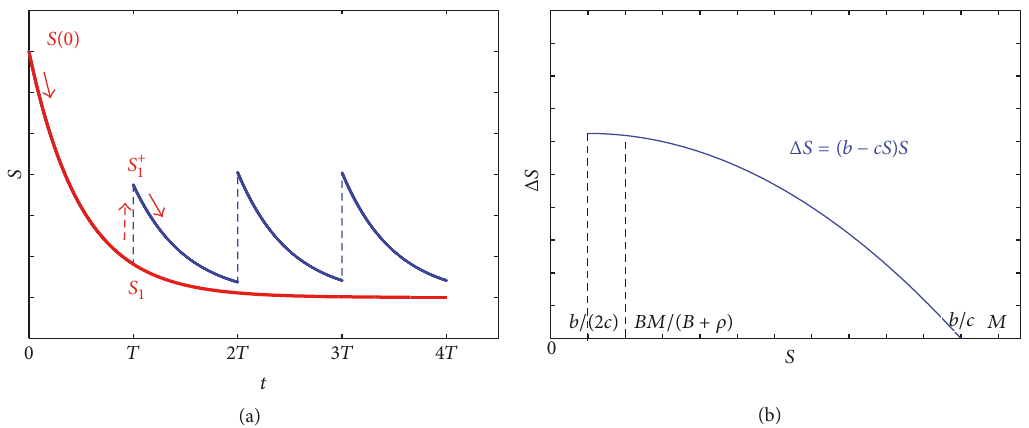
Figure 1: (a) The solutions of (1) and (4) from the initial point (0, 𝑆(0)) ; (b) sketch of Internet sales promotion